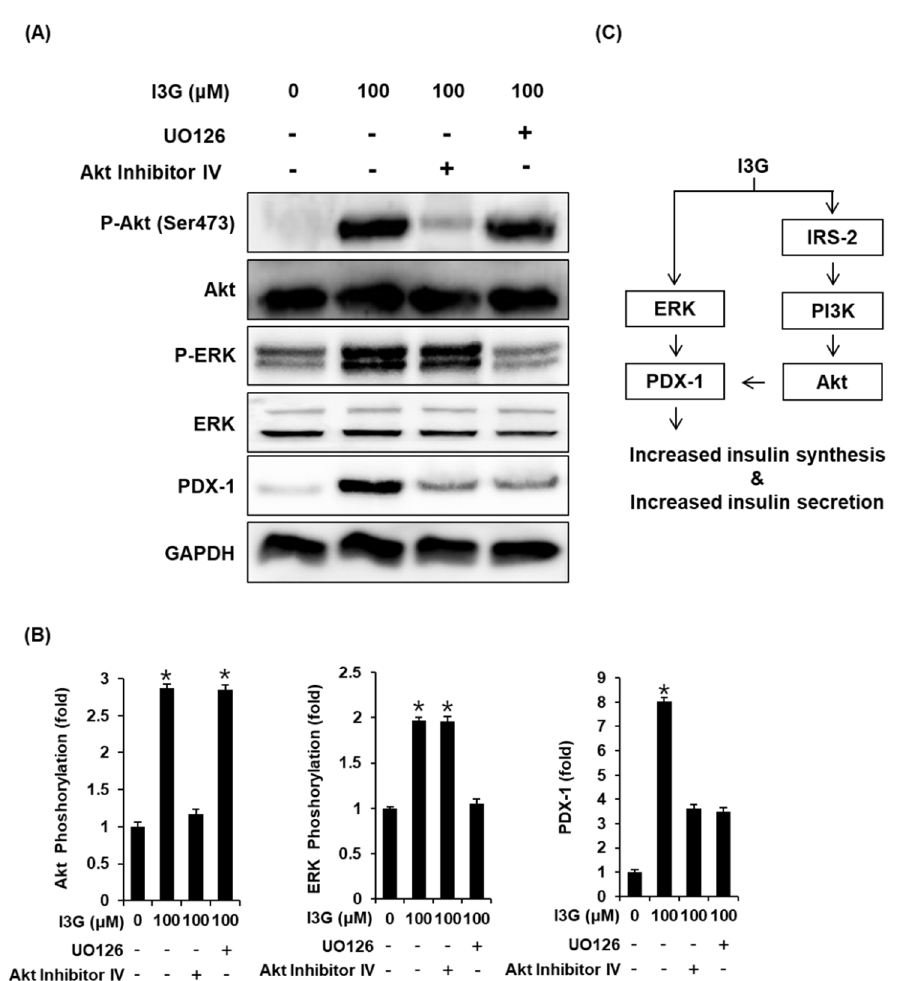
Figure 5. ( A ) Protein expression levels of phospho-Akt (P-Akt) (Ser473), Akt, phospho-extracellular signal-regulated kinase (P-ERK), ERK, pancreatic and duodenal homeobox-1 (PDX-1), and glyceraldehyde 3-phosphate dehydrogenase (GAPDH) in INS-1 cells treated with 100 μM isorhamnetin 3- O -glucoside (I3G), and/or ( B ) U0126 (ERK inhibitor, 10 μM) or Akt Inhibitor IV (Akt inhibitor, 500 nM) for 24 h. ( B ) Bar graphs present the densitometric quantification of western blot bands ( n = 3 independent experiments, * p < 0.05, Kruskal–Wallis nonparametric test). Data are expressed as the mean ± SEM. ( C ) Schematic illustration of the effects of I3G isolated from ethanolic extract of Salicornia herbacea (ESH) on the protein expression levels related to pancreatic β-cell metabolism.